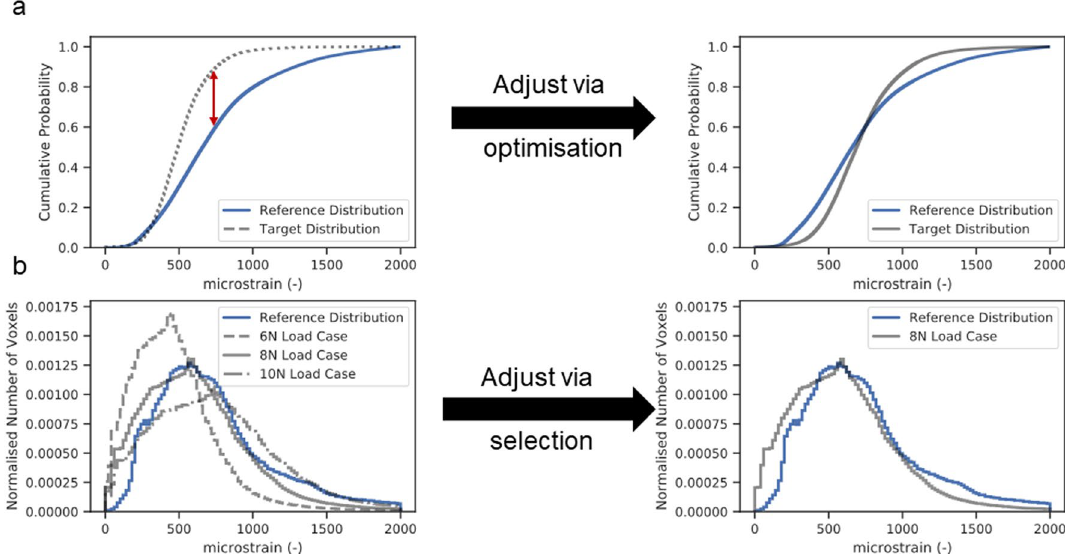
Figure 6. Two approaches can be implemented for the rtFE approach. Optimising via a Kolmogorov–Smirnov test ( a ) allows an automated process, saving time and giving an exact value, while plotting and selecting ( b ) from a list of loading options provides the researcher with more understanding of the strain distributions for each loading